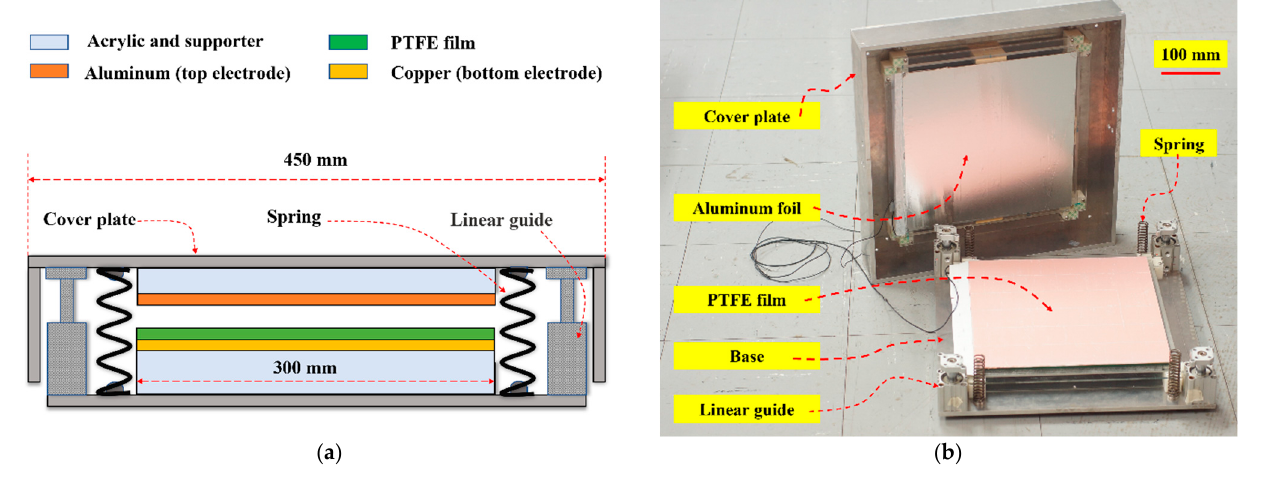
Figure 7. Structural components of TEHFT prototype: ( a ) cross-section; ( b ) photo.